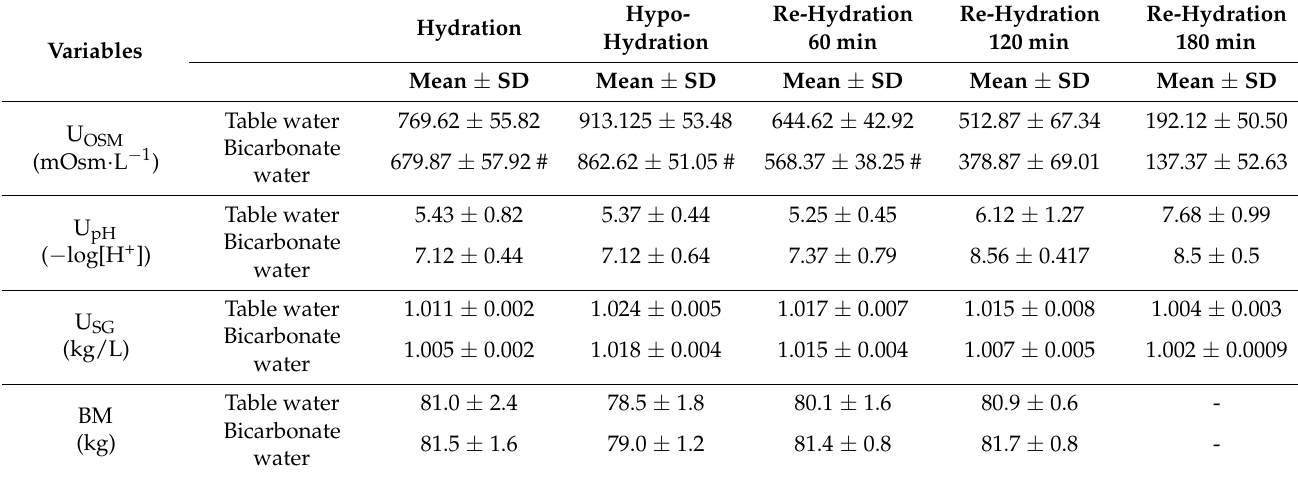
Table 5. The differences in hydration variables after table water and bicarbonate-rich water